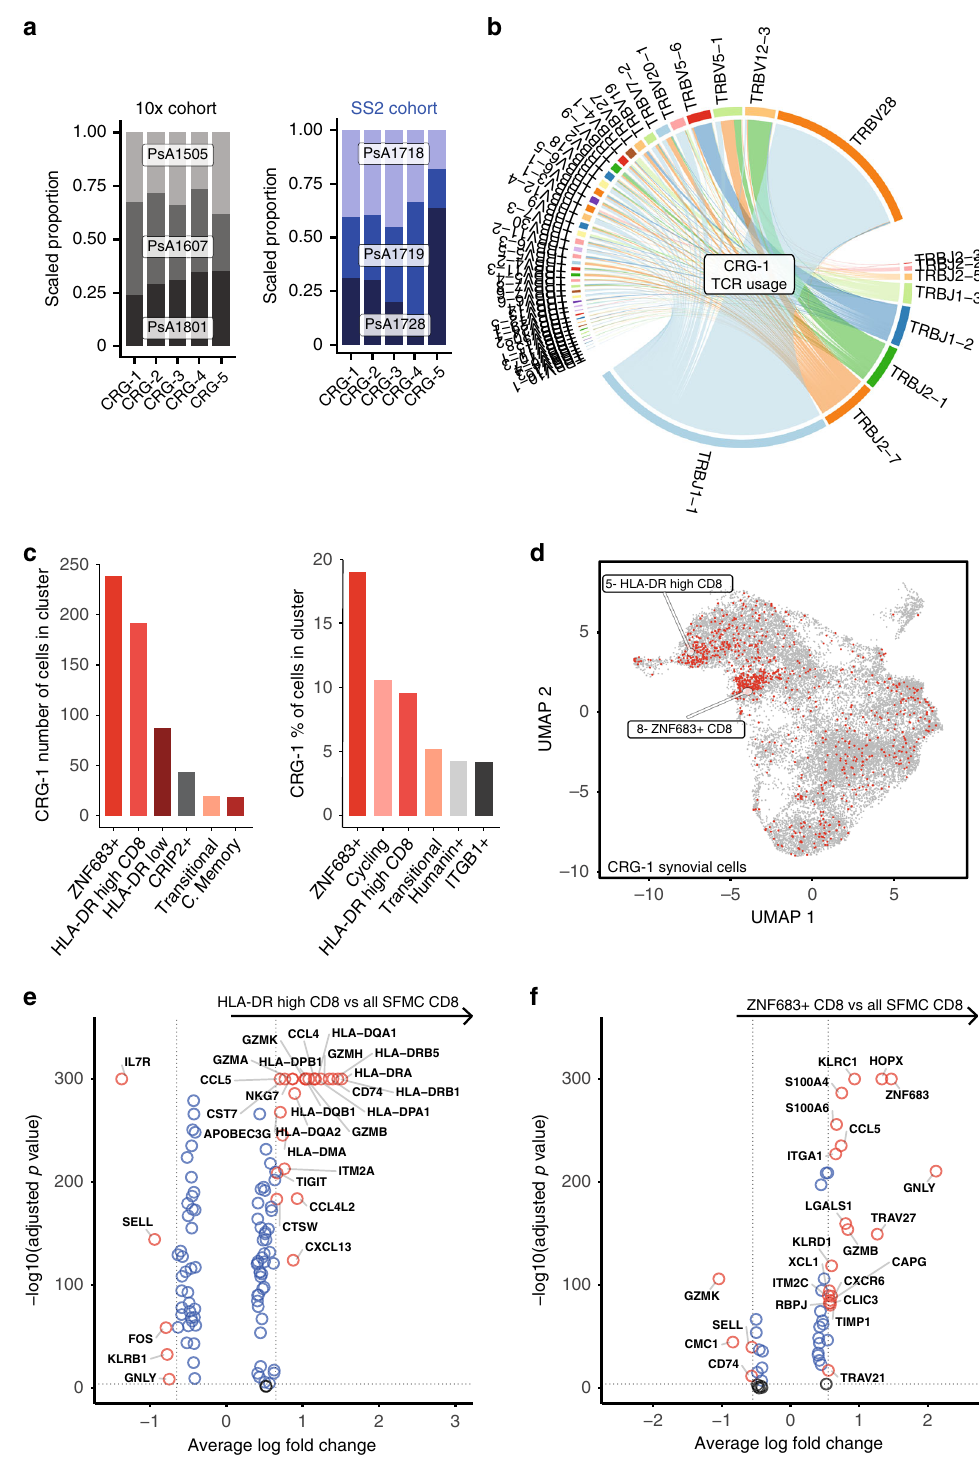
Fig. 4 T-cell receptor convergence in PsA synovial clones. a Patient distribution of top 5 GLIPH convergence groups (CRG) in 5 ′ 10× (grey) and SS2 (blue) datasets. b TCR beta-chain V- and J-gene usage by GLIPH CRG-1 clones. c Distribution of CRG-1 CD8 cells within each of the synovial T-cell clusters by number and as a percentage of the clusters. Top six clusters shown in each graph, statistics in Supplementary Data 7b. d Cells from CRG-1 highlighted on UMAP plot of all SFMC-derived T cells from 5 ′ 10× data set. e , f Volcano plots showing differential gene expression of synovial CD8 T cells in the HLA- DR-high cluster ( e ) and ZNF683 + cluster ( f ), against all other synovial CD8 T cells (Supplementary Data 3d, e, respectively). Two-sided Wilcoxon Rank Sum test with Bonferroni correction, labelling cut-offs for average logFC ± 0.65 ( e ), ±0.55 ( f ) and adjusted p value ( ≦ 1E − 04) indicated by dotted lines. Source data are provided as a Source Data fi